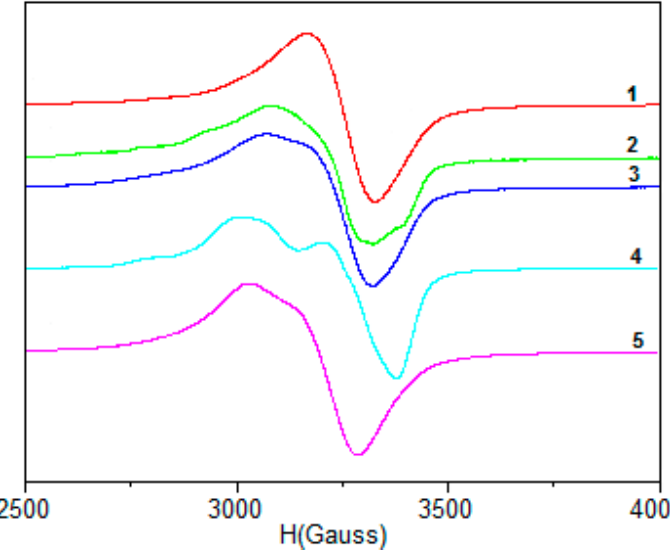
Figure 2. EPR spectra of complexes 1 – 5 in the polycrystalline state at 298 K.